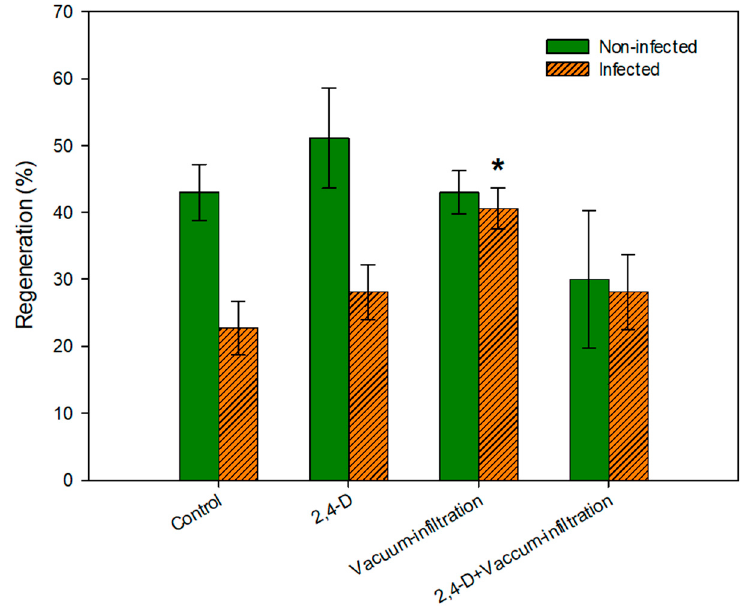
Figure 2. Effect of 2,4-D, 20 min of vacuum-infiltration and the combination of both treatments on adventitious shoot regeneration from hypocotyl slices of non-infected ‘Canino’ mature seeds (green) and infected with Agrobacterium harboring the plasmid pMOG-eyfp-IV2 (orange with striped pattern). Data were collected six weeks after the beginning of the experiments. Asterisks denote significant differences in regeneration percentages with the control according to specific contrasts ( p < 0.05) within non-infected or infected explants.